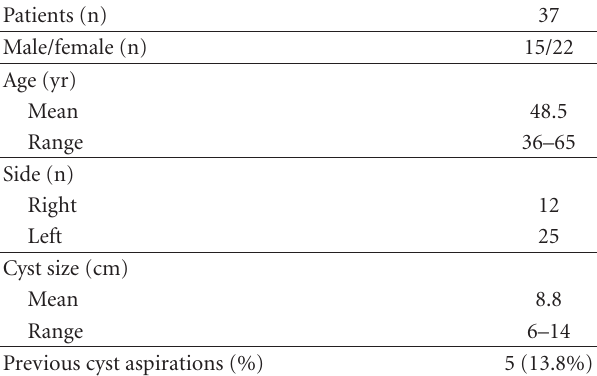
Table 1: Patient characteristics and preoperative